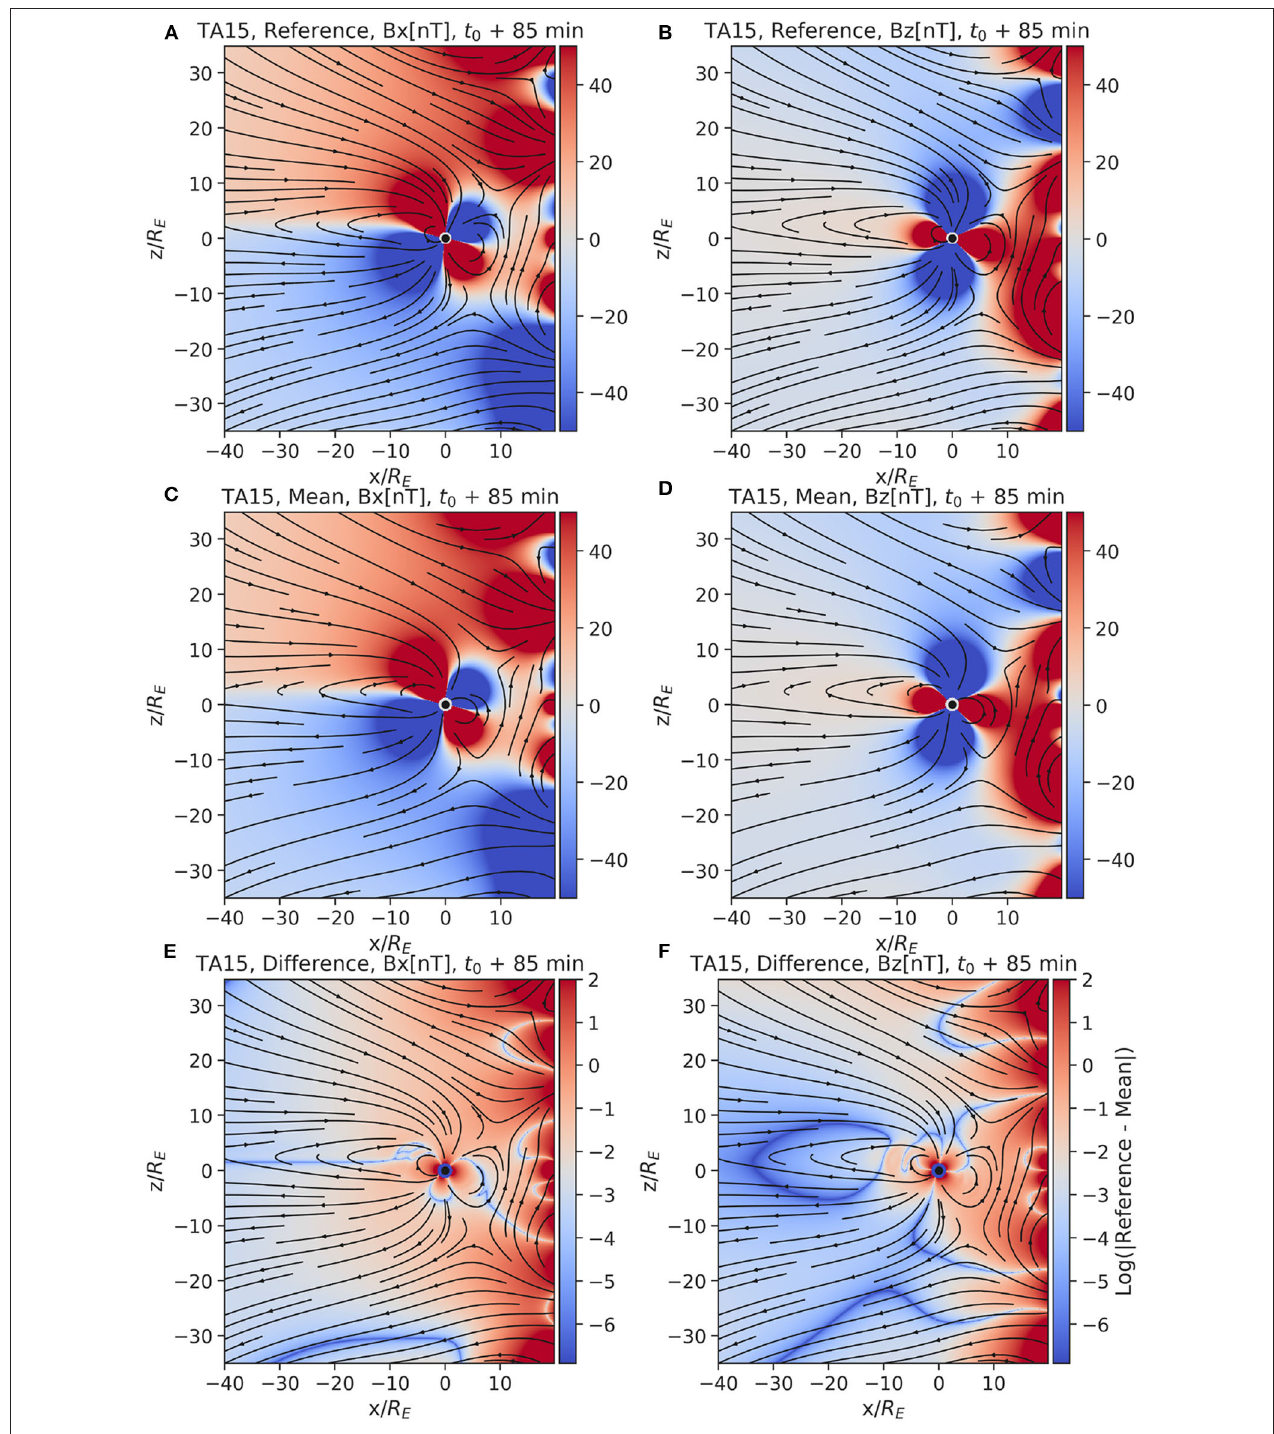
FIGURE 8 | The reference and mean magnetic field ( B x : (A,C) and B z : (B,D) respectively) at time t 0 + 85 min from the Tsyganenko TA15 model are displayed in the top two rows of figures. Notice the non-realistic high magnetic field values in the inflowing solar wind (at x / R E > 10). We assume these unrealistic values are necessary for the model to construct the day-side magnetosphere. The values of the magnetic field have been cut off in the top two rows of figures at | 50 nT | , to make sure the variations in the tail are visible. The last row (E,F) of figures shows the logarithm of the absolute error between the reference simulation and the mean of the ensemble.